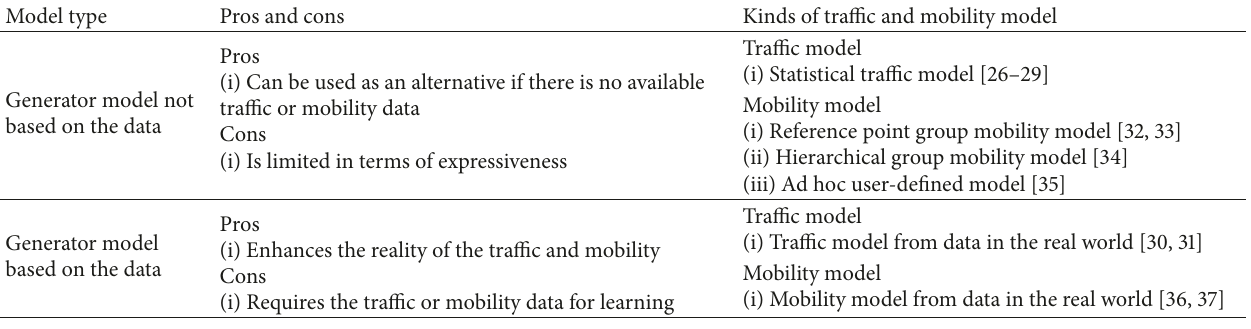
Table 1: Related works for construction of the traffic and mobility model.